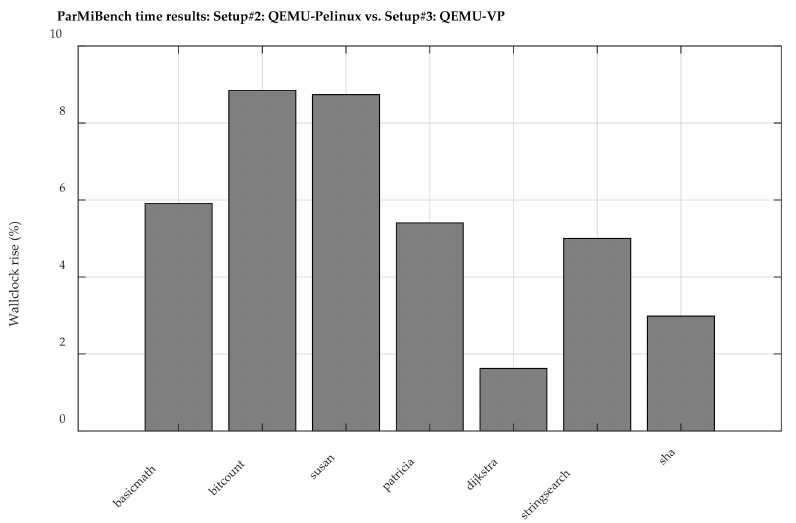
Figure 10. Wallclock time comparation for ParMiBench. Setup#2 QEMU-PetaLinux vs. Setup#3 QEMU-VP.